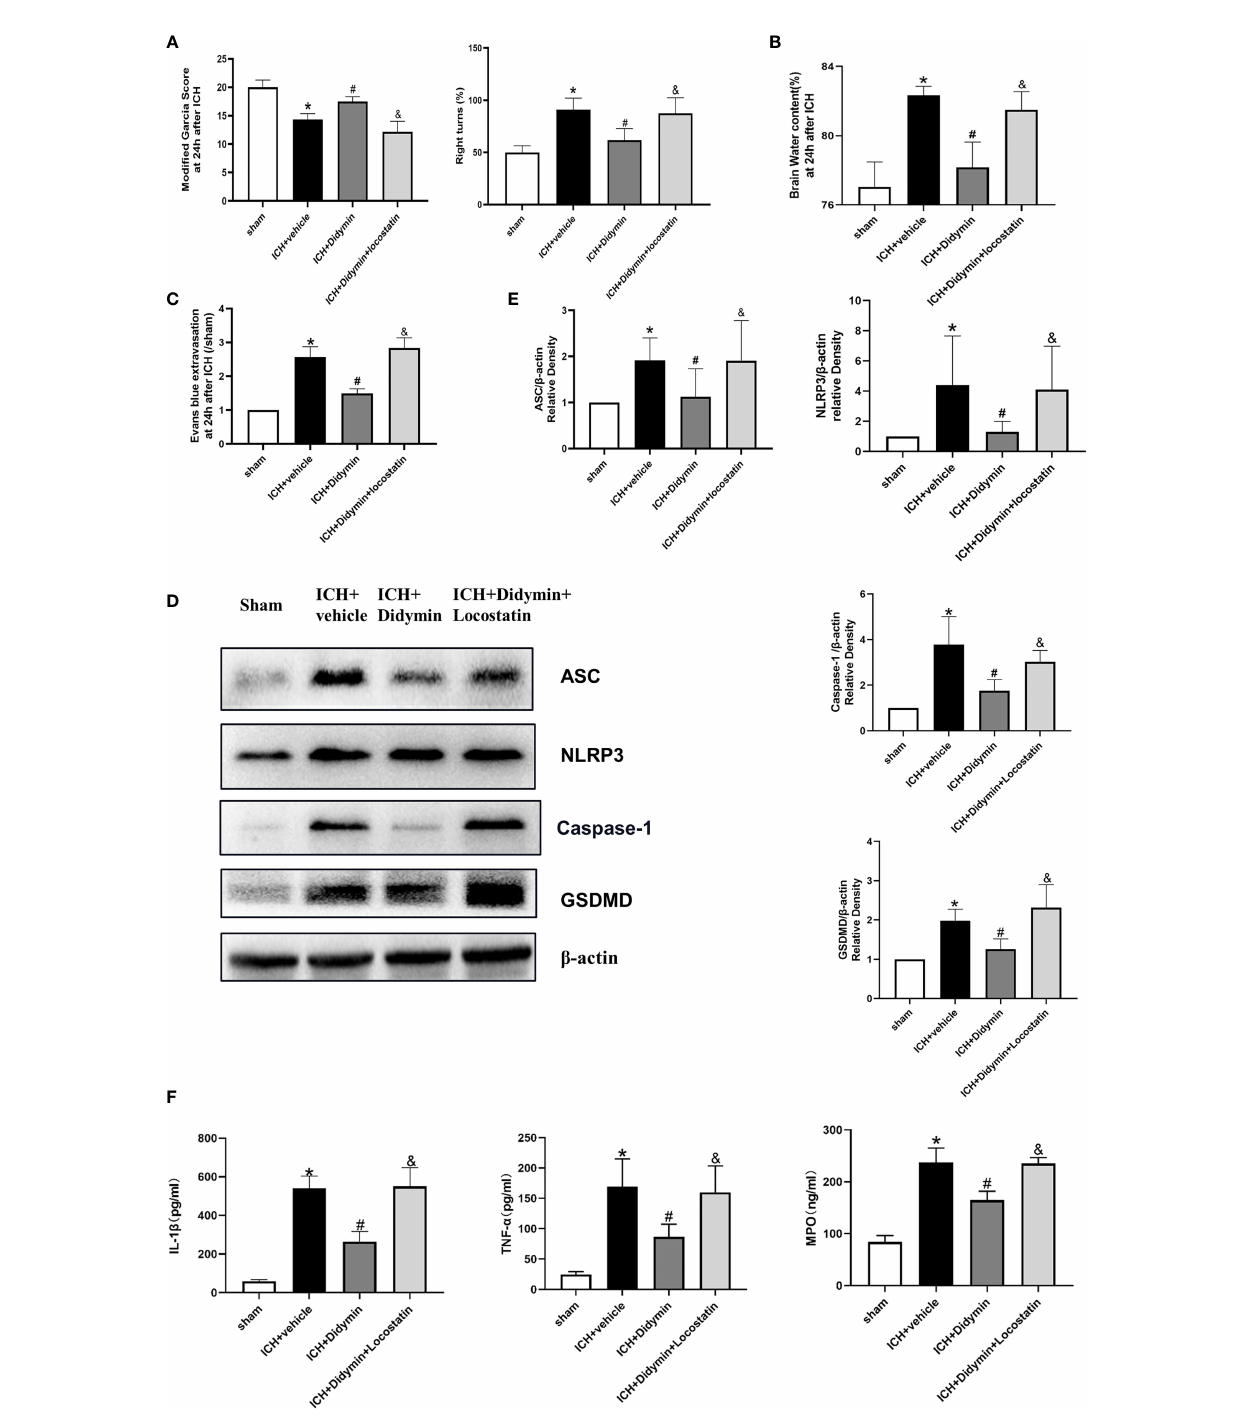
FIGURE 6 | Locostatin abolished the neuroprotective effects of Didymin. (A – C) Neurological de fi cits, brain water content, and EB extravasation were tested at 24 h after ICH. (D, E) Representative Western blot bands and densitometric quanti fi cation of Asc, Nlrp3, Caspase-1, and GSDMD. n = 6 for each group. * p < 0.05 vs. sham; # p < 0.05 vs. ICH+vehicle. & p < 0.05 vs. ICH+Didymin. (F) IL-1 b , TNF- a , and MPO production was detected by ELISA assay kit. n = 6 for each group. * p < 0.05 vs.sham; # p < 0.05 vs. ICH+vehicle. & p < 0.05 vs.